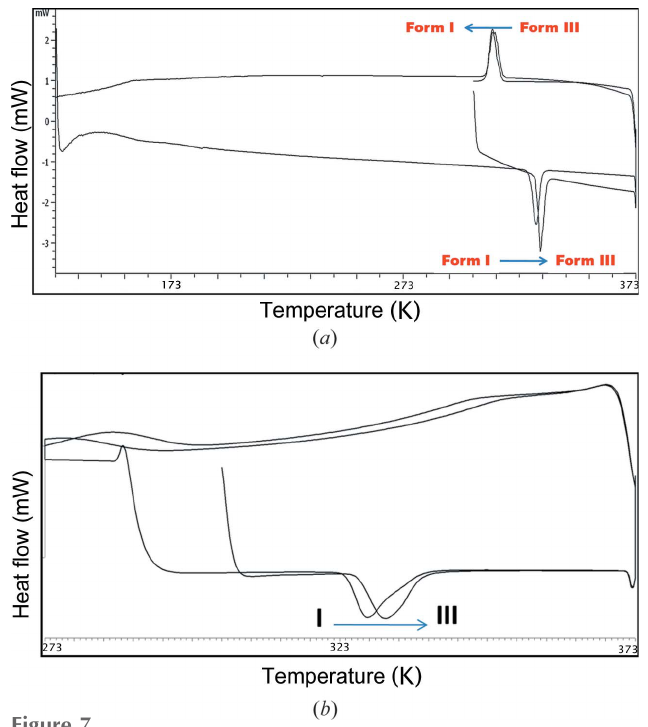
reheat). ( b ) DSC thermogram of Compound-A Form I ground material (heat–cool–reheat).